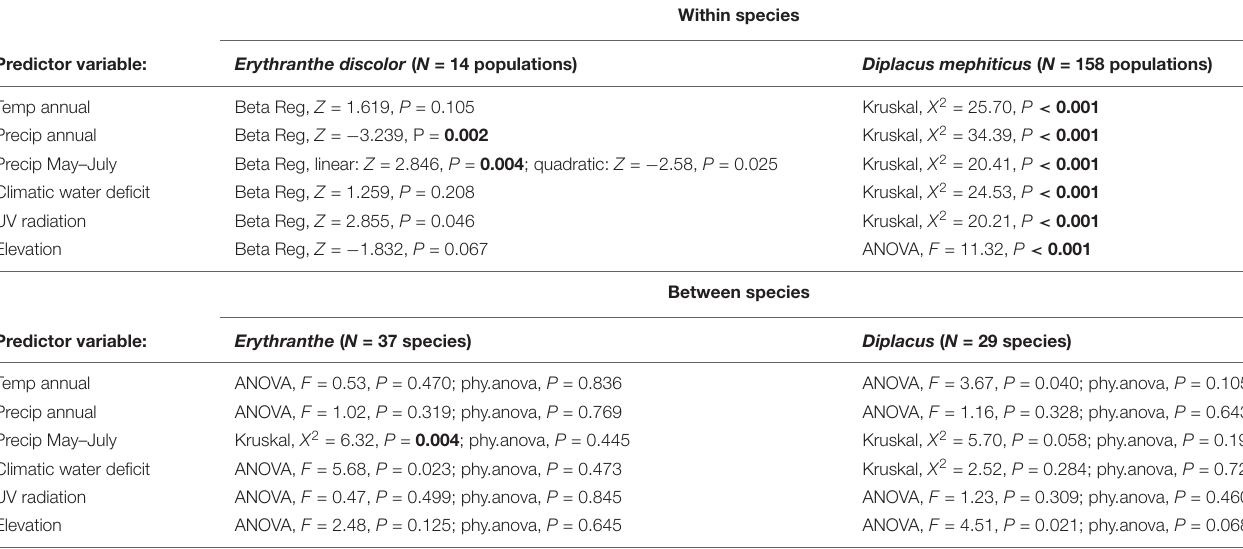
FIGURE 3 | Within-species variation in climate, UV, and elevation affinity by primary flower color category, displayed as boxplots. Filled circles represent observed data for each color category. Lines represent the predicted slope from beta regression and letters indicate post hoc comparisons where P < 0.05. Opaque plots are those without significant predictors after correcting for multiple tests. See Table 1 for statistical results. TABLE 1 | Results of models analyzing the relationship between abiotic environmental variables and flower color. Within